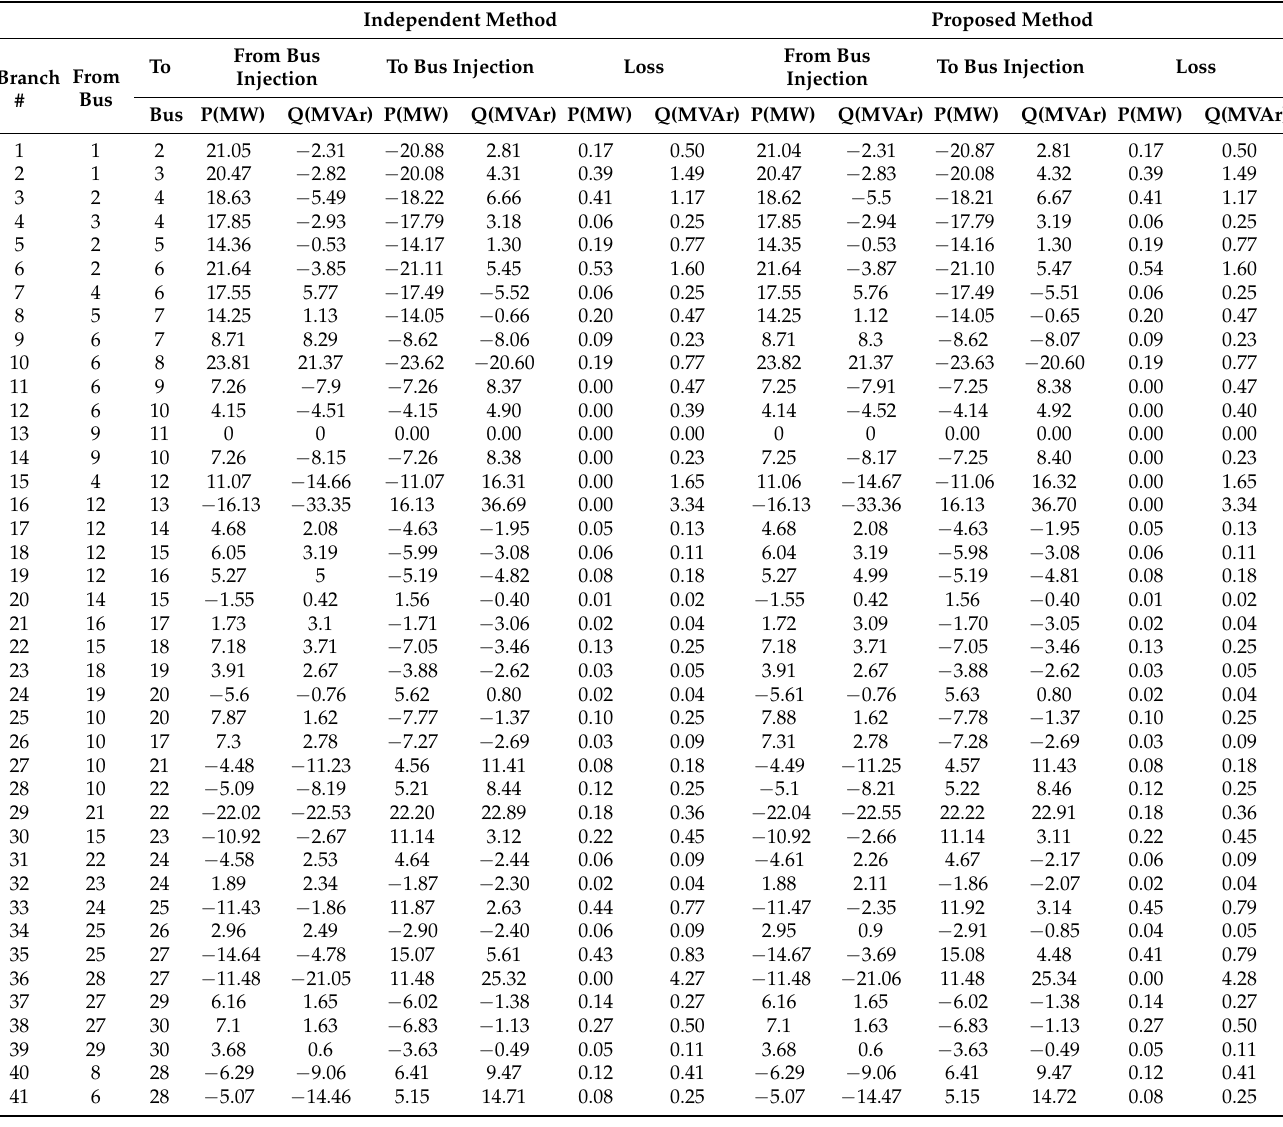
Table A1. Branch power flow in TSO with different methods evaluated on test case